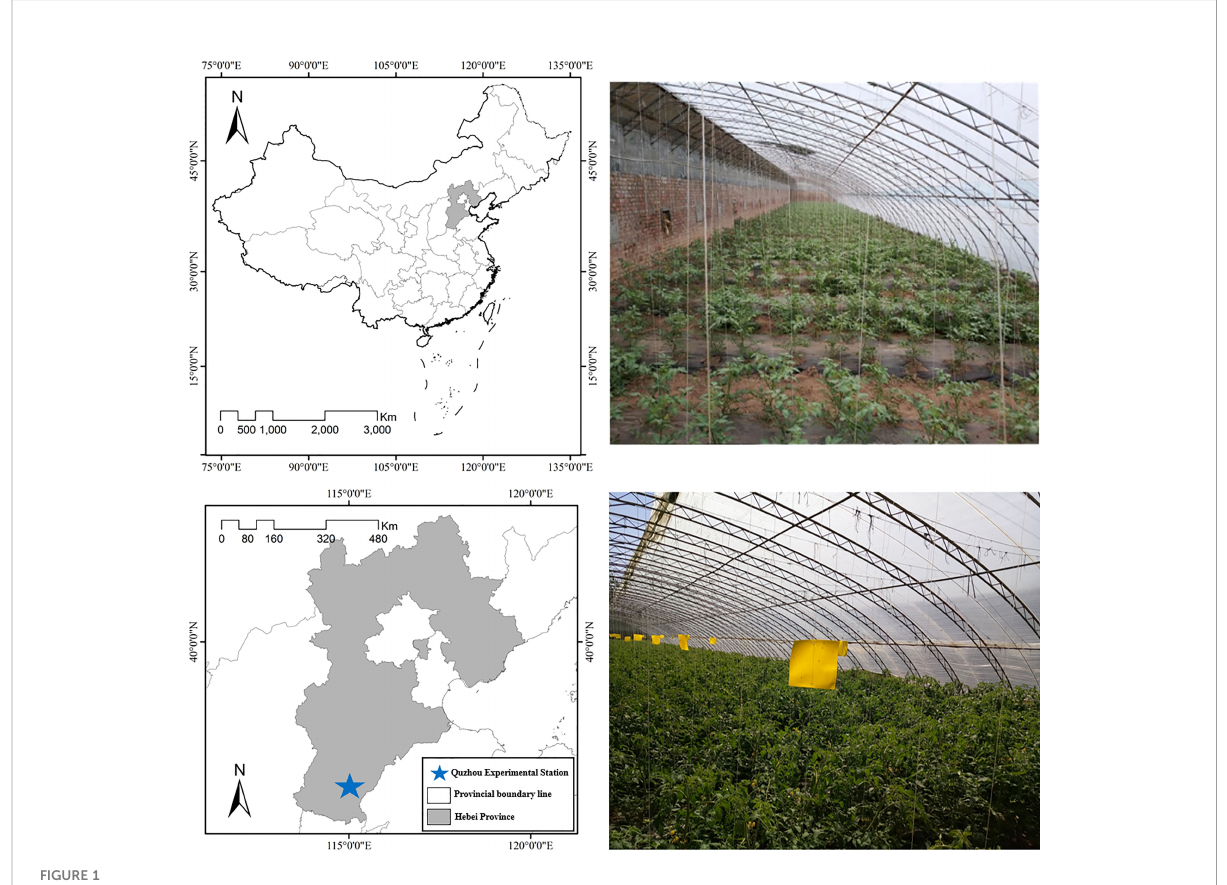
FIGURE 1 Location of study site for different